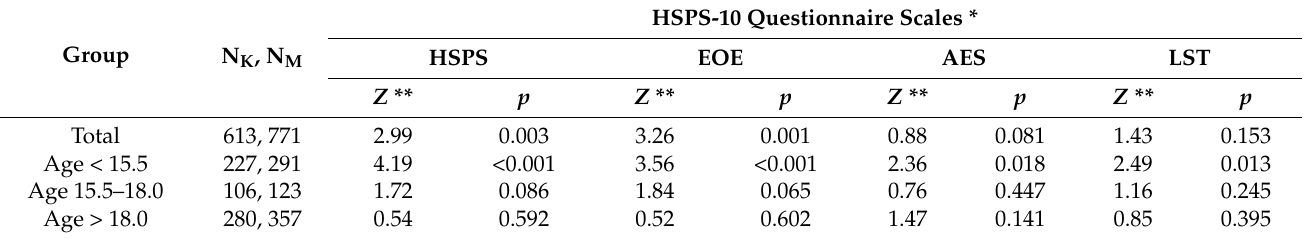
Table 5. Comparison of the results of the short version of the HSPS-10 for both sexes in different age